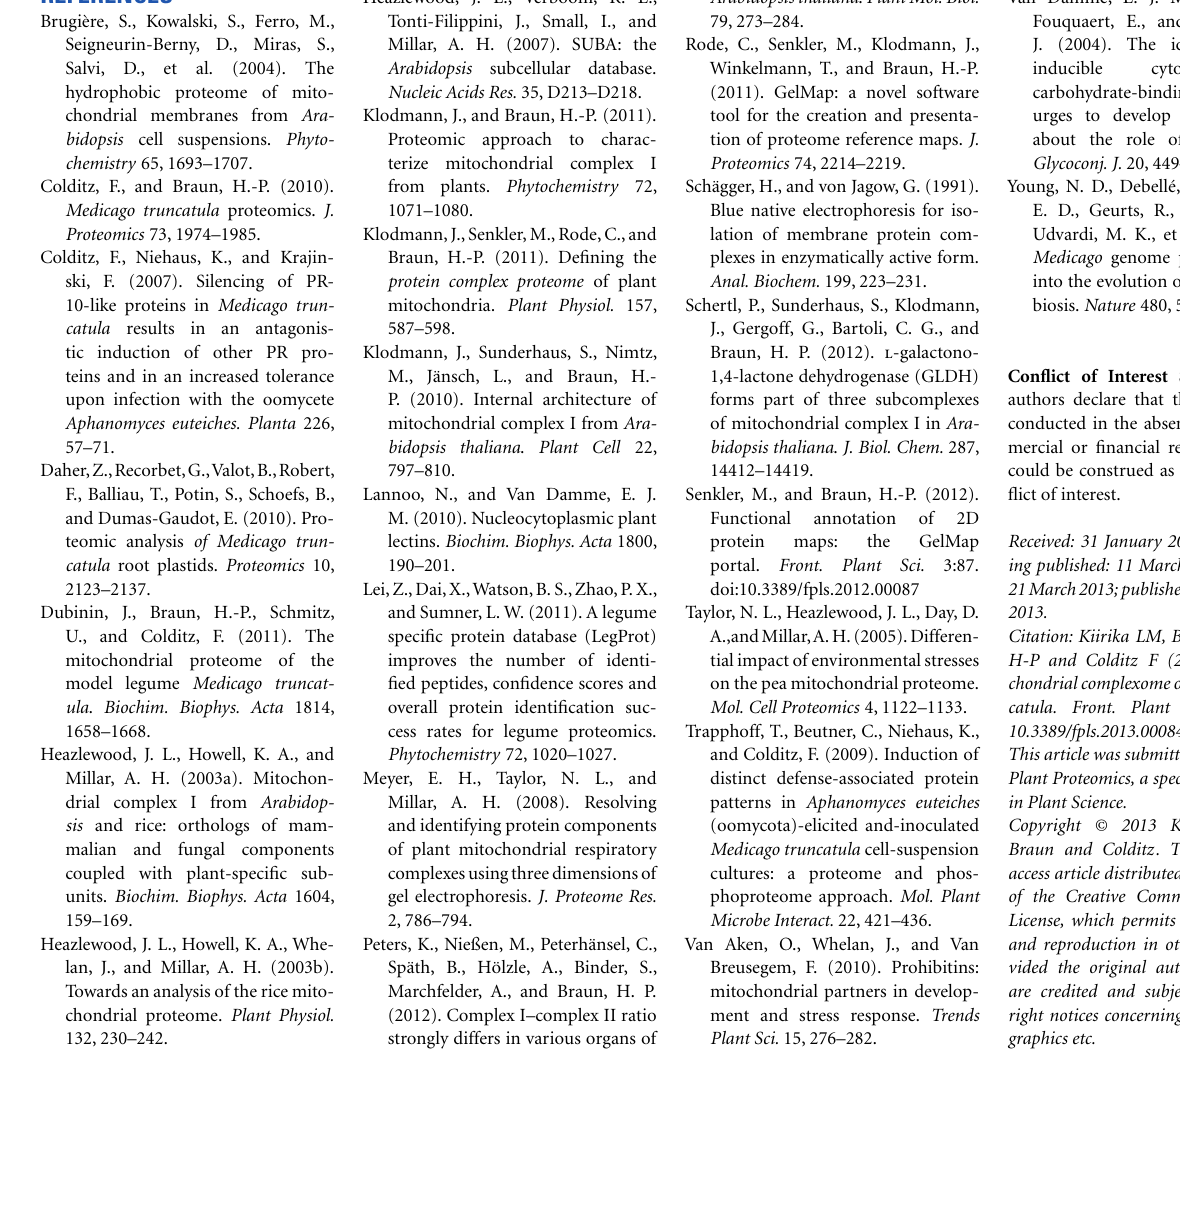
Figure S3 | Spot detection on the 2D BN/SDS gel done automatically using DELTA 2D software package (version